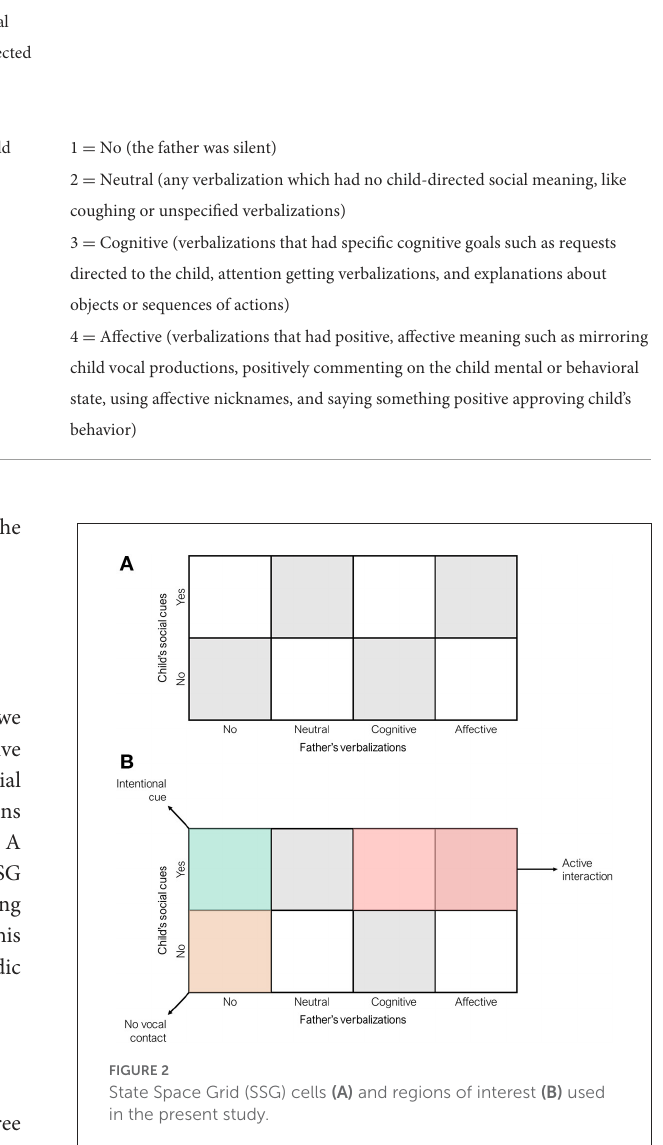
ratings for Adam and his father are reported in the additional